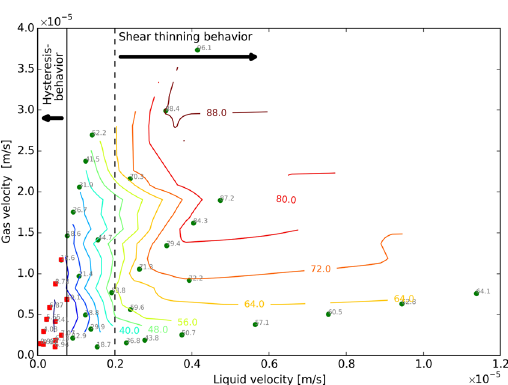
Figure 6. The steady-state pressure gradient in pa/m for coinjection of 0.5 wt% AOS 14–16 and nitrogen into a Bentheimer sandstone core. The circle and square markers represent the measurements, and the solid lines are the contour plots, obtained by the 2D spline interpolation. The red squares depict the points for which the hysteresis behavior in foam generation was observed. The vertical black solid line indicates the liquid velocity below which the foam generation exhibits hysteresis behavior. The vertical dashed line indicates a minimum liquid velocity above which the foam has a shear-thining